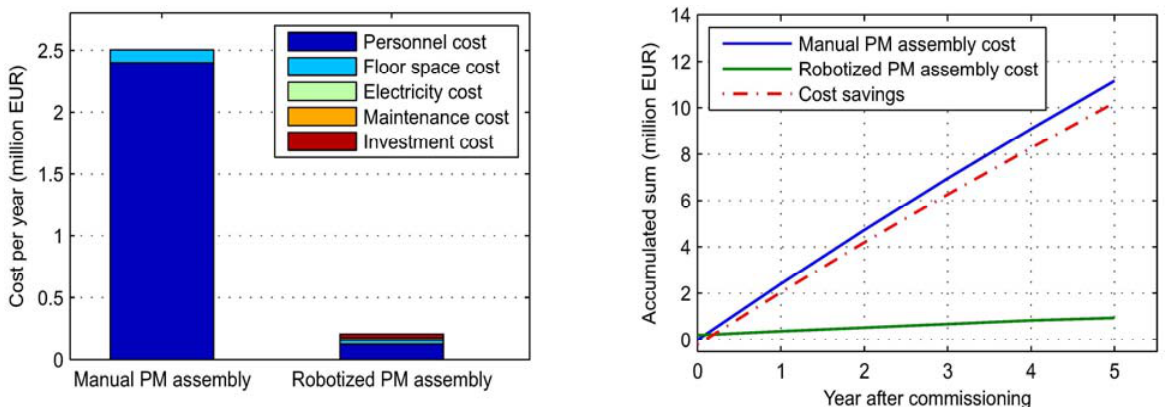
Figure 8. ( a ) Yearly costs divided into major cost units. ( b ) Accumulated costs and cost